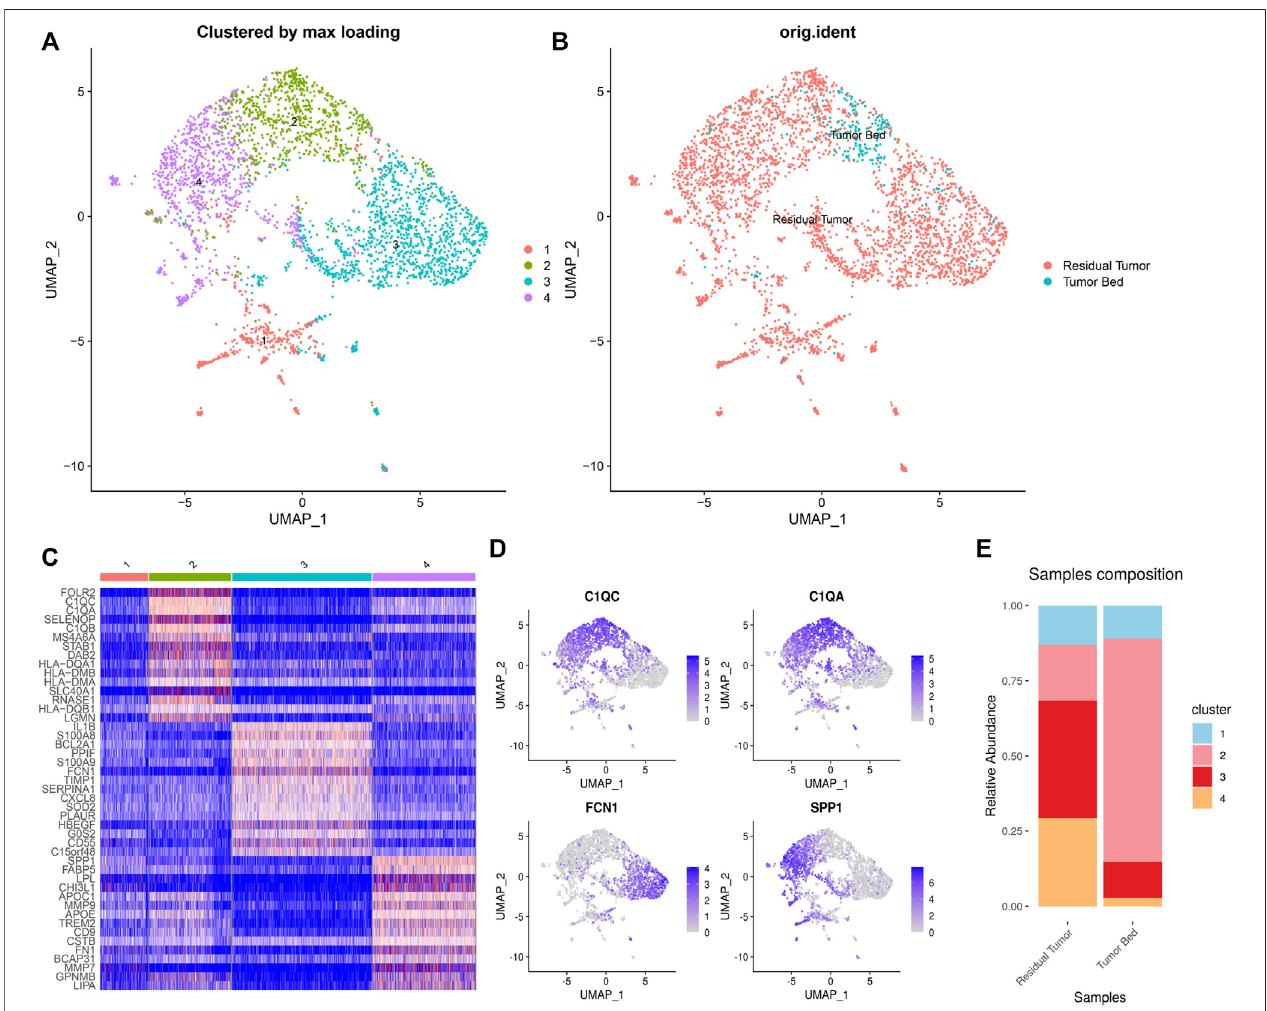
FIGURE5 | Heterogeneityof macrophages inOSCC after ICT. UMAP plot showing thesubclustersdivided using NMF (A) and the original ident (B) . Marker genes expression shown in heatmap, highlighting three classic subgroups of TAMs (C2 – 4). C2 TAMs expressed C1Qs. C3 CAFs expressing FCN1. C4 CAFs expressed SPP1 (C) . Feature plots showing C1QC, C1QA, FCN1, SPP1 expression in TAMs (D) . The proportion of subclusters in residual tumor and tumor bed (E) .